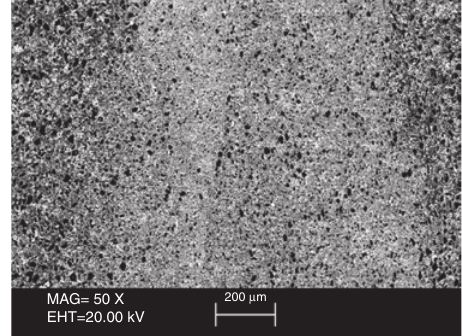
Figure 8 SEM microstructure image of the N3 sample.